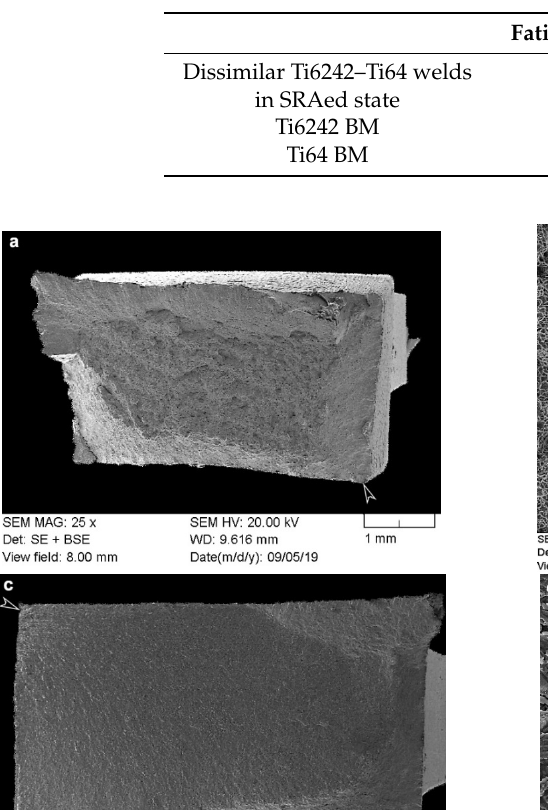
Figure 8. Comparison of fatigue life curves at room temperature and R = 0.1 for the Ti6242 and Ti64 BMs relative to the dissimilar Ti6242–Ti64 linear friction weld in the SRAed condition: ( a ) semi-log scale plot of the maximum stress versus the number of cycles to failure (N f ) in the (low cycle fatigue) LCF and high cycle fatigue (HCF) regimes and ( b ) double log scale plot of the maximum stress versus the number of reversals to failure (2Nf). Table 4. Comparison of the fatigue limit of dissimilar Ti6242–Ti64 welds with that of the Ti6242 and Ti64 BMs at 107 cycles.